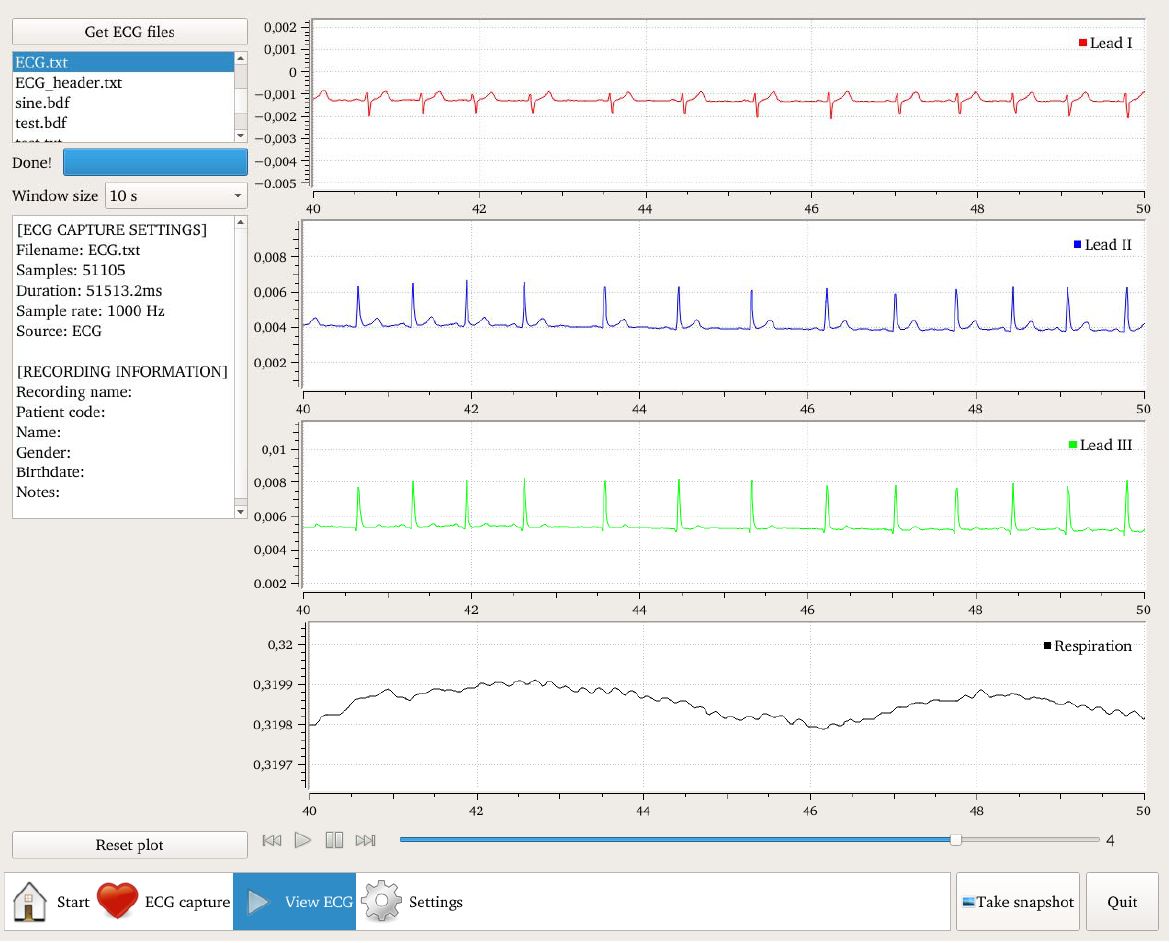
Figure 5. The prototype of Version A; PCB Layout with specified functional blocks (to the right) and assembled PCB (to the left). 4mm air clearance for creepage currents required by IEC 60601 can be recognized by black hachures in the layout and correspondent dark green area (area without copper) in the assembled PCB.